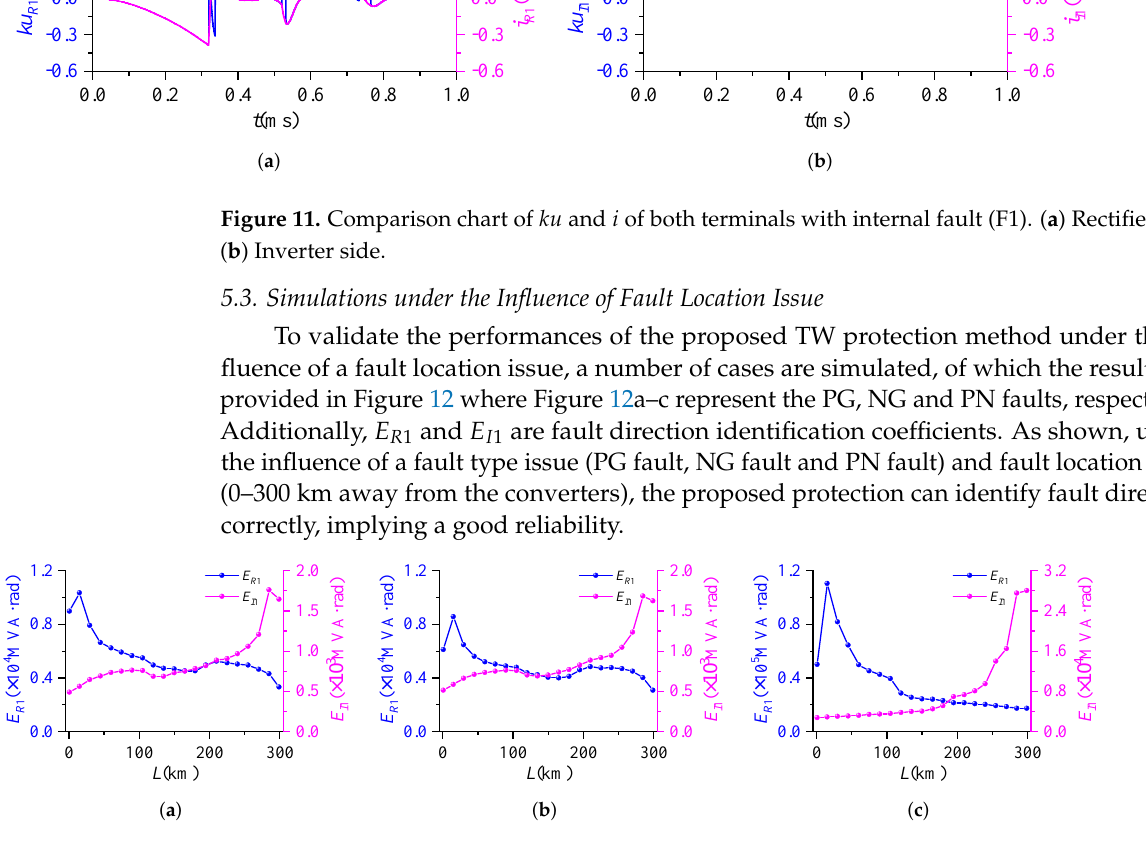
Figure 12. Fault direction identification coefficients with different fault locations. ( a ) PG fault. ( b ) NG fault. ( c ) PN